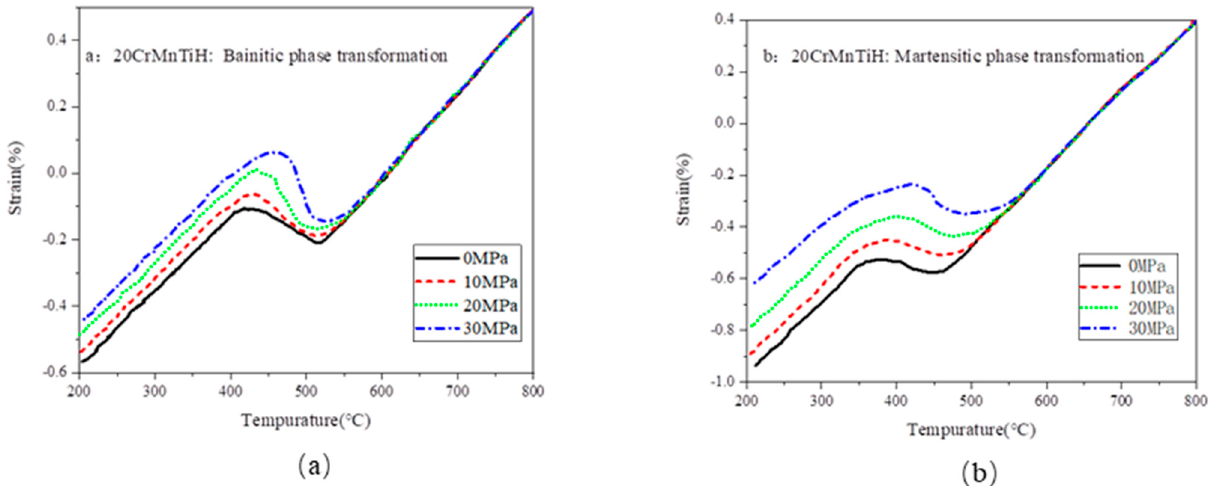
Figure 6. Temperature–strain diagrams of the 20CrMnTiH steel. ( a ) Temperature–strain diagram of the bainitic phase; ( b ) temperature–strain diagram of the martensitic phase.